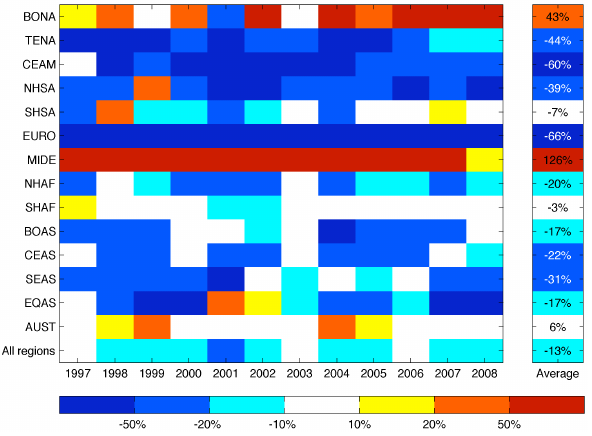
Fig. 16. Differences in fire carbon emissions estimates between GFED3 and GFED2, as a percent of GFED2 estimates. Positive numbers indicate GFED3 is higher than GFED2 and vice versa.